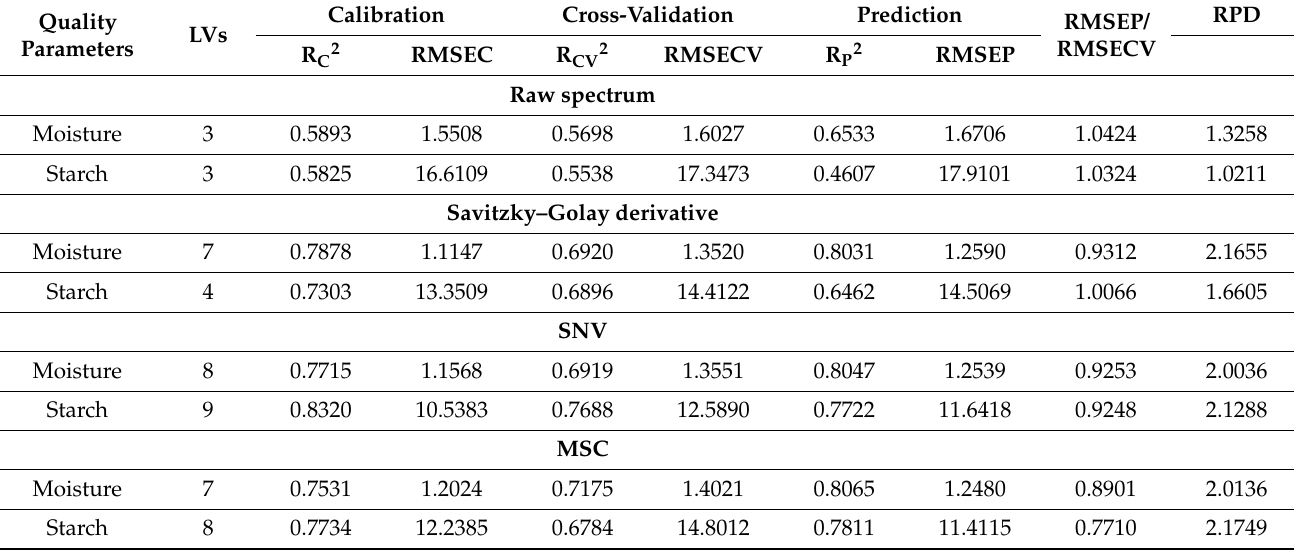
Table 1. Calibration, cross-validation, and prediction results of PLS model for assessing internal quality of sweet potatoes.